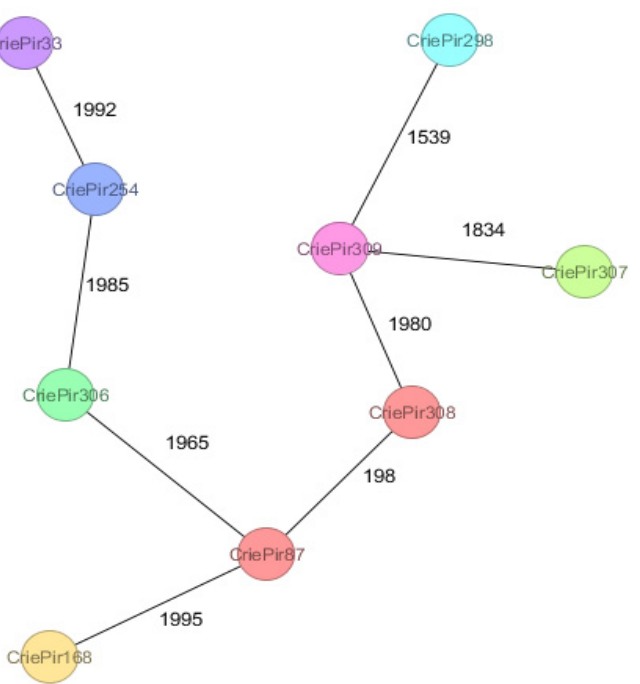
Figure 1. The minimum spanning tree for the isolates studied based on cgMLST profiles. The numbers indicate the amount of different alleles between the pairs of corresponding isolates. Close isolates (CriePi87 and CriePi308) are shown in the same color; other isolates are not close to each